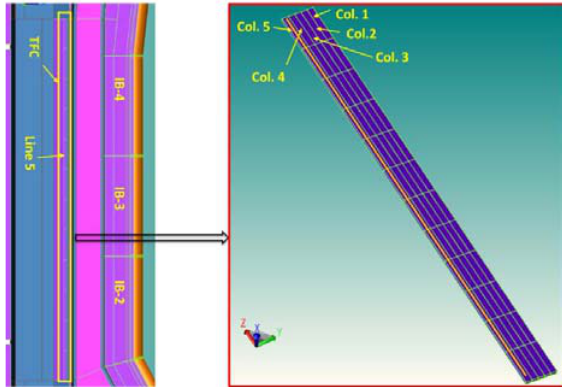
Figure 8. Tally cells for radiation loads on